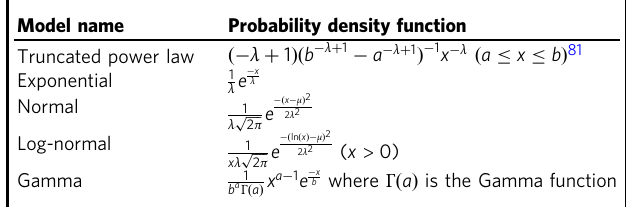
Table 1 Tested probability density functions.